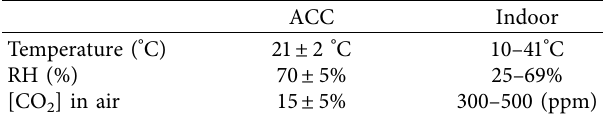
Figure 2: (a) Accelerated carbonation chamber. (b) Coated concrete sample. (c) Removing unwanted dust. (d) Concrete cubes after coating. Table 3: Environmental conditions during the carbonation test